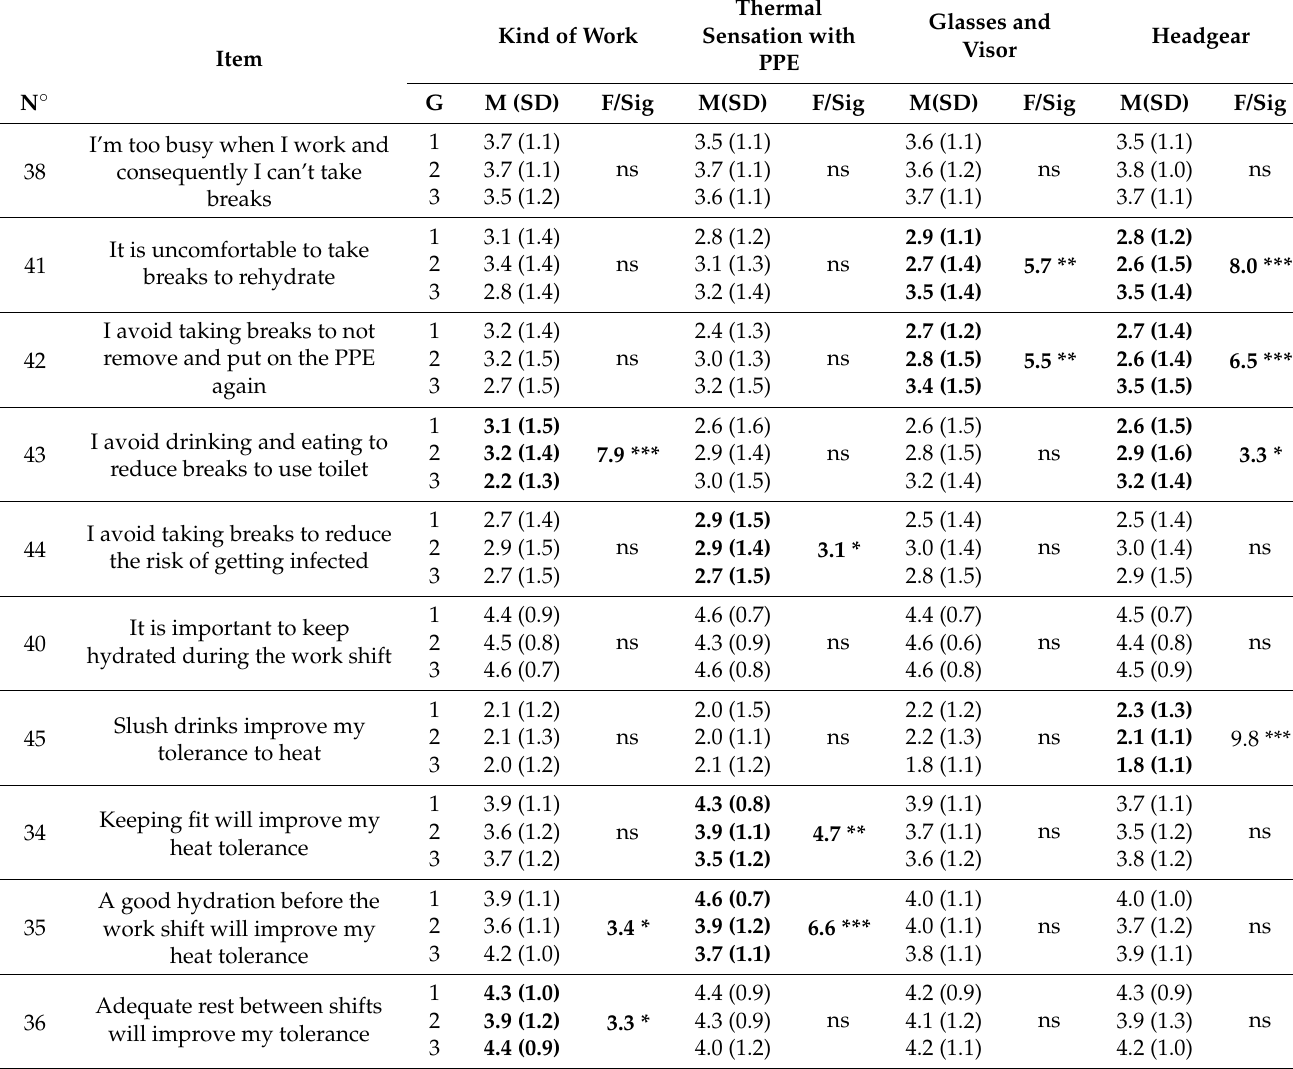
Table 5. Difference between groups concerning issues related to worker’s behavior and awareness of good practices to increase the heat tolerance. Item